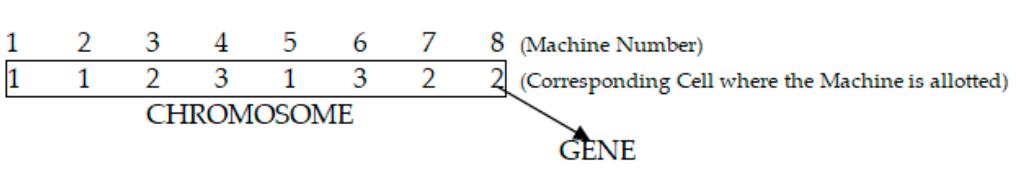
Figure 1. Representation of a chromosome using real coding.